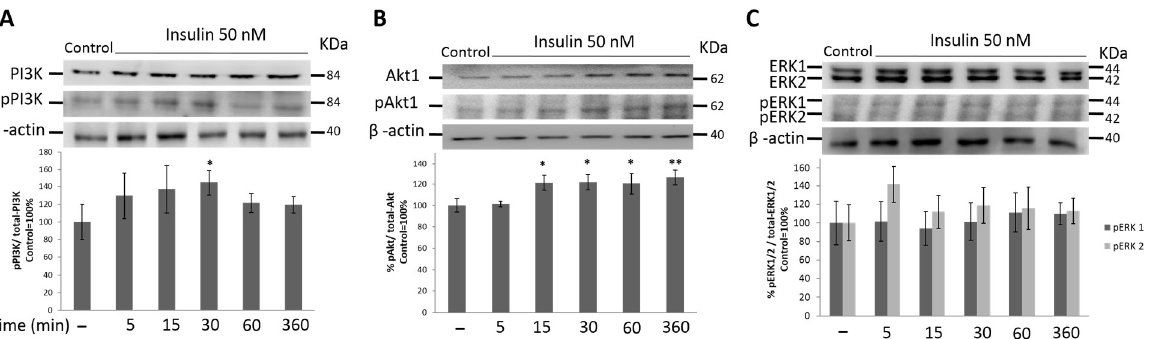
Figure 4. Cervical cancer cells express higher phosphorylation levels of PI3K/Akt1 than ERK1/2 in response to insulin treatment. ( A ) PI3K, phospho PI3K. ( B ) Akt1, phospho Akt1. ( C ) ERK1/2 and phospho ERK1/2 protein levels were analyzed by WB in whole-cell lysates from HeLa cells stimulated with 50 nM insulin. Data are representative of 3 independent experiments. Graphics show densitometric analysis of total levels and phosphorylated protein. The first bar is the control group without treatment. All experiments were performed in three independent experiments in triplicate, and experimental data were expressed as mean ± standard deviation (SD). * p < 0.05 and ** p < 0.01 compared to control (taken as 100%).